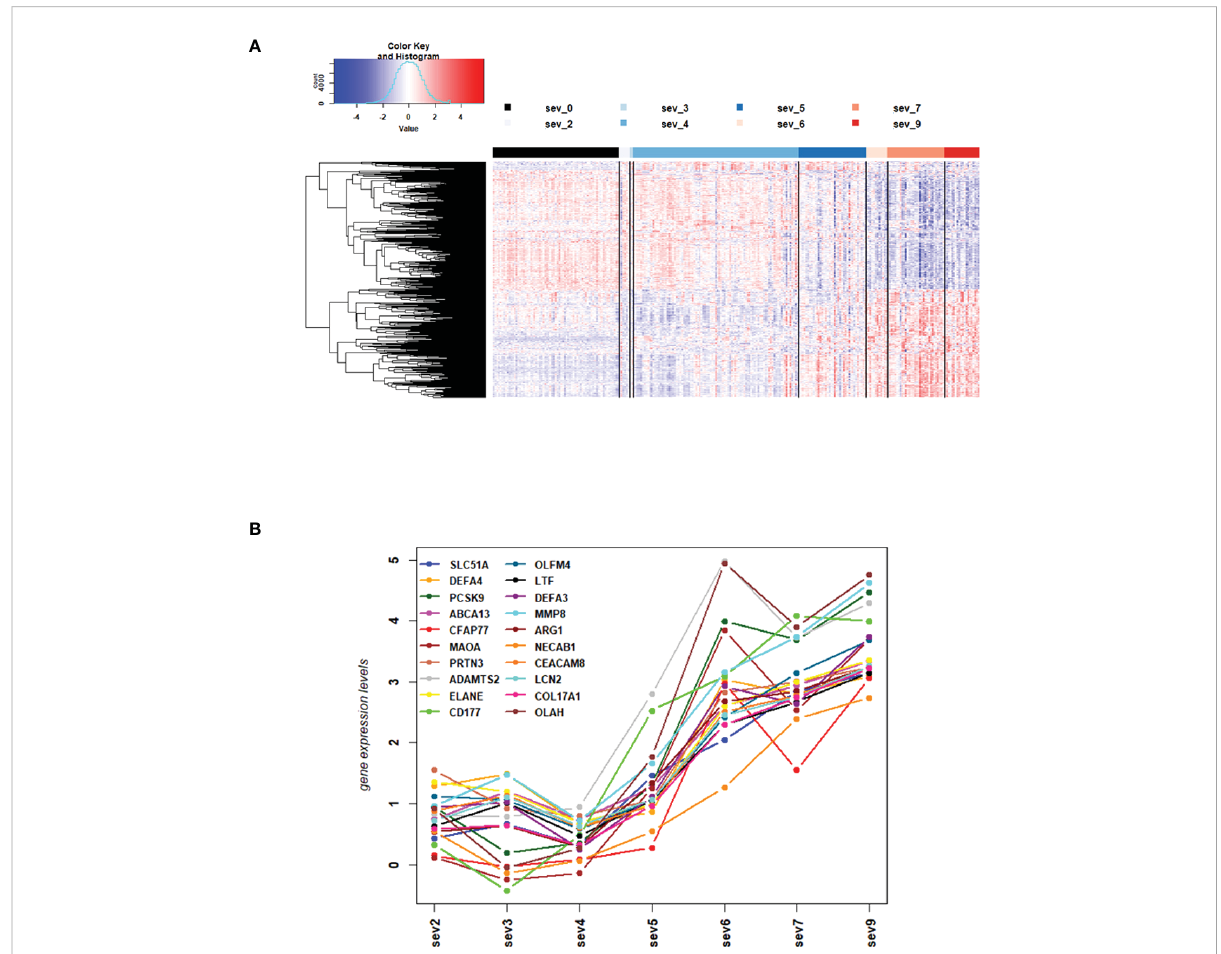
FIGURE 2 DEGs from comparisons of WHO severity level groups. (A) Heatmap of expression levels for top 500 DEGs from the comparison of WHO severity levels 7 + 9 versus 4 + 5. Values were scaled by row. red: up-regulated DEGs, blue: down-regulated DEGS, sev0 to sev9: severity levels 0 to 9, respectively. (B) Mean gene expression differences for all severity levels compared to healthy controls for top 20 up-regulated DEGs from the comparison of WHO severity scores 7 + 9 versus 4 + 5. Y-axis: gene expression differences as log fold change, X-axis: severity level groups. Note that our cohort did not have participants at levels 1 and 8. Abbreviations: sev0, 2, 3, 4, 5, 6, 7, and 9 stand for WHO severity level 0, 2, 3, 4, 5, 6, 7, and 9, respectively. These results demonstrate the intermediate (moderate severity) of levels 5 versus mild severity levels (1-4) and severe levels